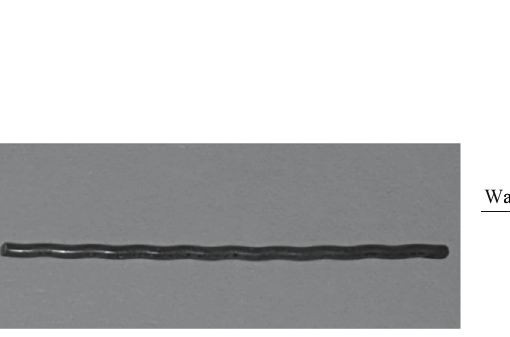
Figure 1: Photo of crimped fi bers and illustration of dimensions.